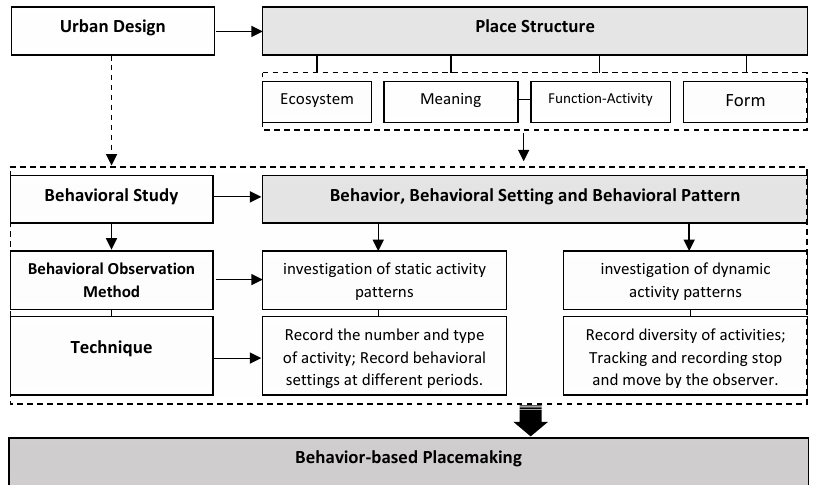
Fig. 2: Proposed Behavior-based Placemaking Model